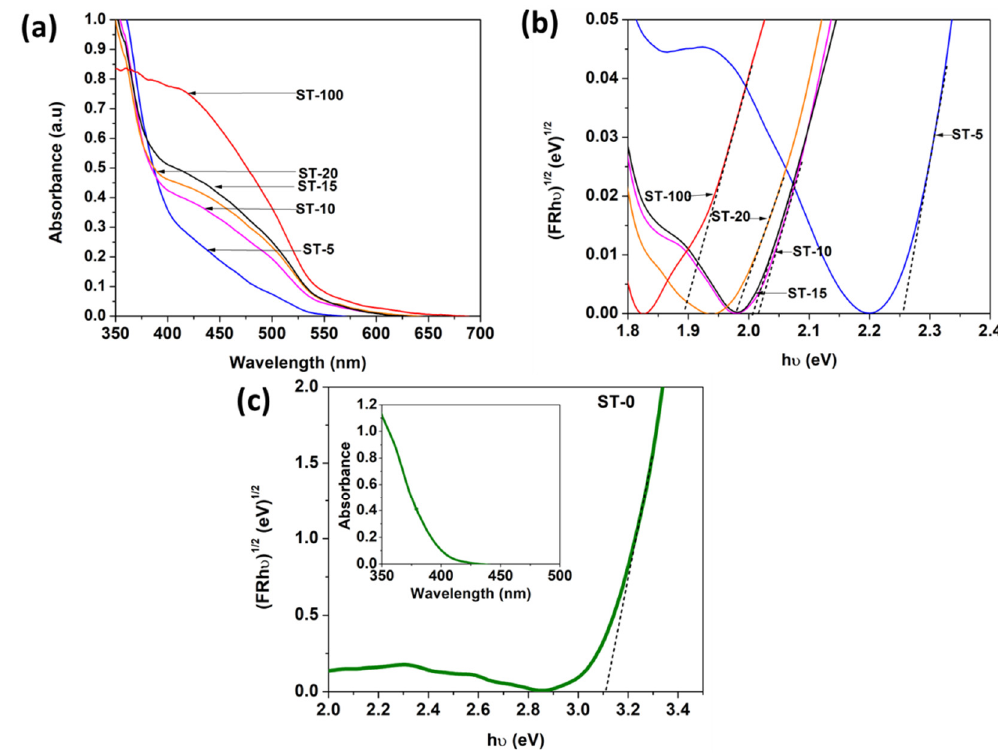
Figure 4. ( a ) Absorption spectra for samples ST-5, ST-10, ST-15, ST-20, and ST-100; ( b ) Tauc plot for S-5, ST-10, ST-15, ST-20, and ST-100 and; ( c ) Tauc plot of pure TiO 2 sample (ST-0) (inset shows the respective absorption spectra).